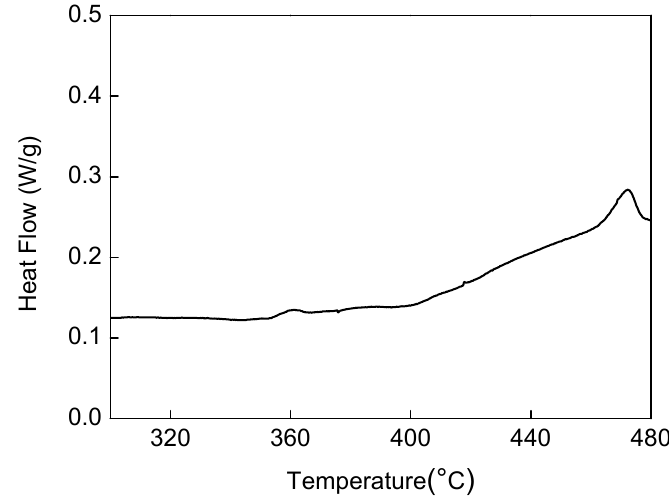
Figure 1. DSC analysis before homogenization.